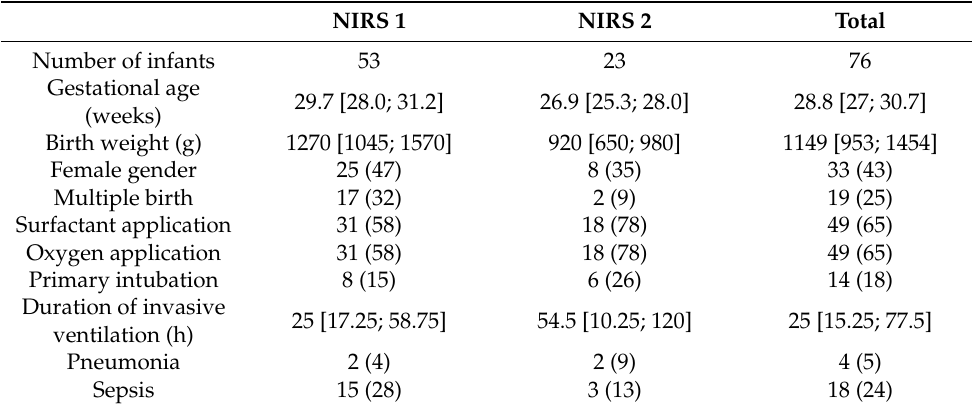
Table 1. Clinical characteristics of the observational study cohorts. Data are given as numbers (percentage) or median (quartile 1; quartile